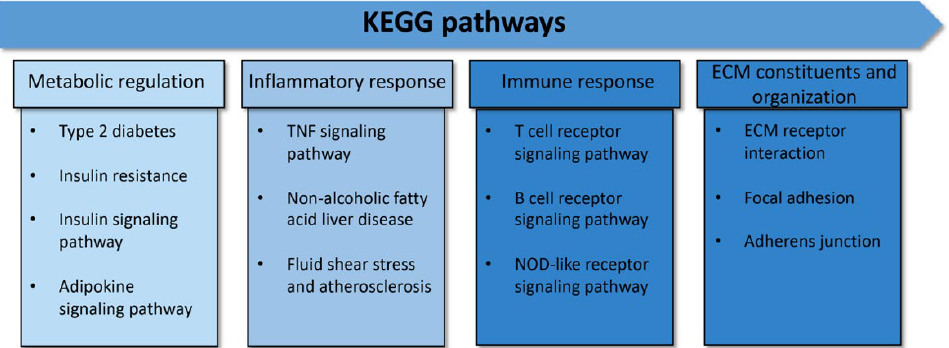
Figure 2. Protein categorization by KEGG pathways. The 13 associated pathways in metabolic disturbance in type 2 diabetes were categorized into 4 major groups: 1. metabolic regulation, 2. inflammatory response, 3. immune response, and 4. ECM constituents and organization.